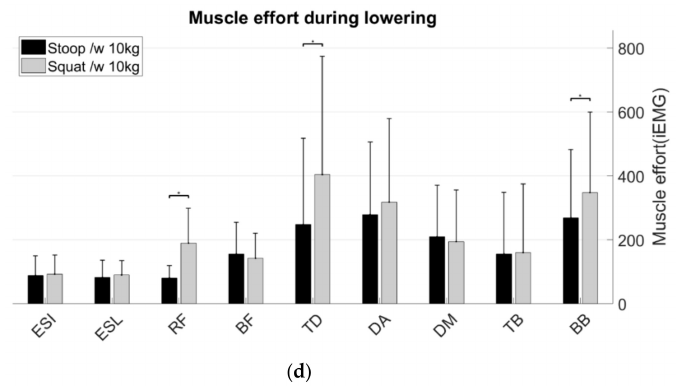
Figure A2. Peak EMG normalized to MVC during the two di ff erent lifting techniques (stoop and squat) for the 10 kg box. Statistical significant di ff erences ( α < 0.05) between the handling phases are indicated with three dots, and statistical meaningful di ff erences between technique and loads are indicated with one dot. Error bars indicate standard deviations. ( a ) Peak measured EMG during the lifting phase in the nine muscles (erector spinae illiocostalis (ESI), erector spinae longissimus (ESL), rectus femoris (RF), biceps femoris (BF), trapezius descendens (TD), deltoideus anterior (DA), deltoideus medius (DM), triceps brachii (TB), and biceps brachii (BB)); ( b ) muscle e ff ort during lifting for the same nine muscles.; ( c ) peak EMG during the lowering phase for the nine muscles; ( d ) muscle e ff ort during the lowering phase for the same nine muscles.